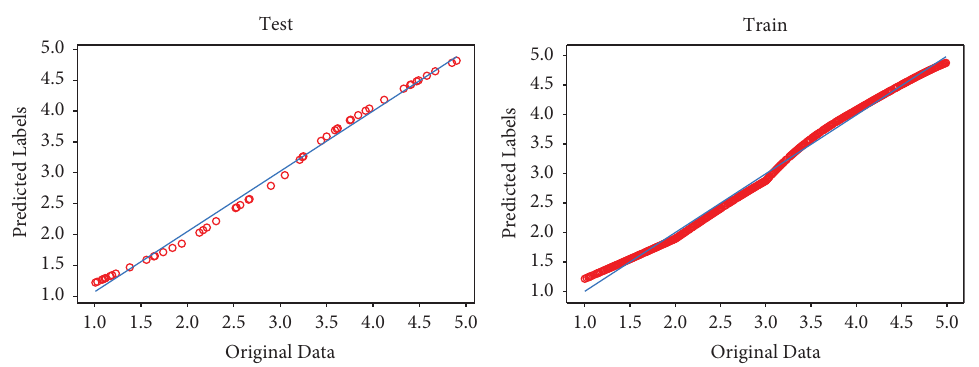
Figure 11: Dispersion of test data (a) and training (b) in the predicted SVR